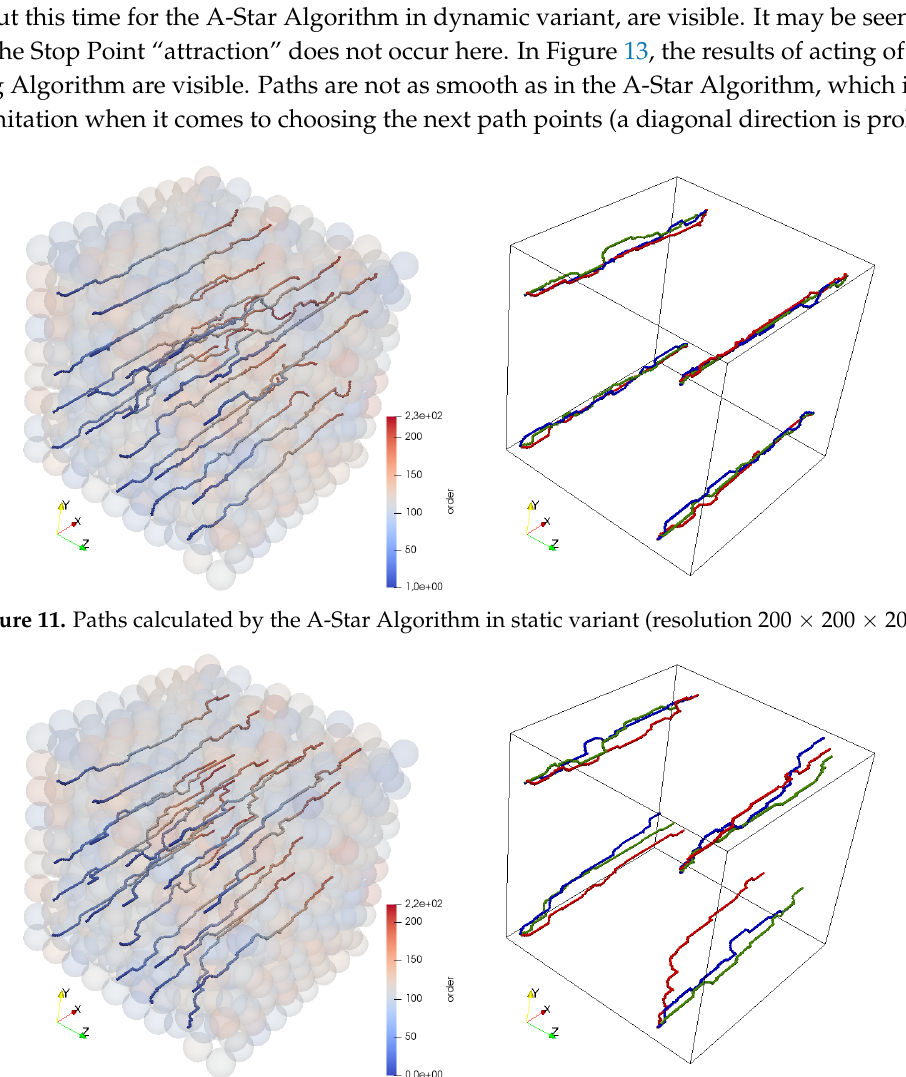
Figure 12. Paths calculated by the A-Star Algorithm in dynamic variant (resolution 200 × 200 ×